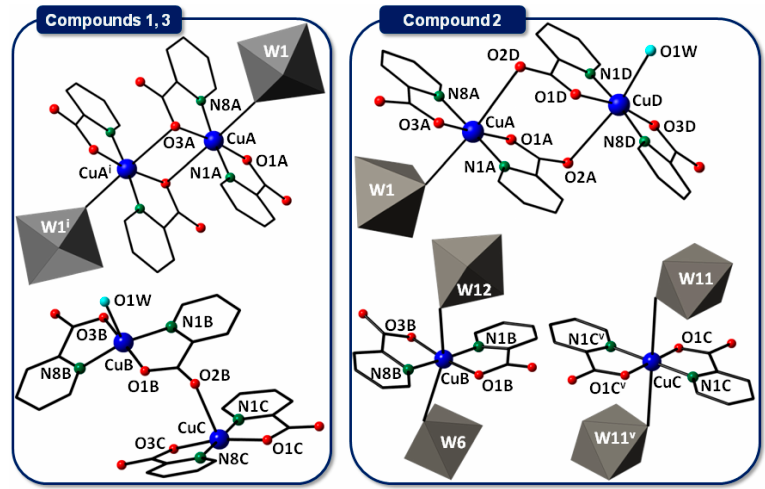
codes i and v see Table